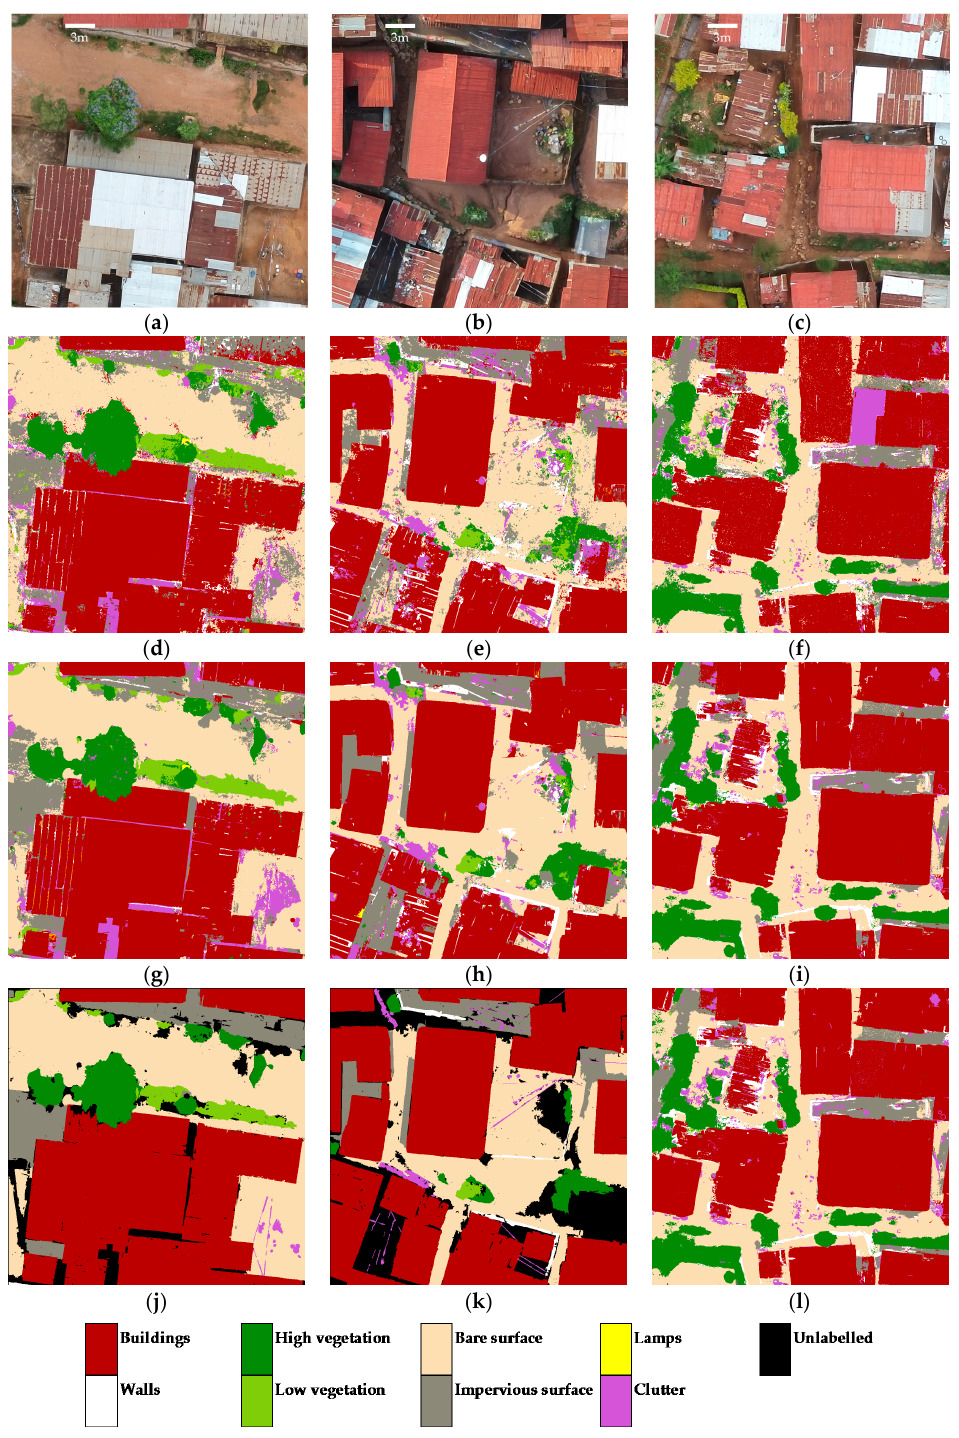
Figure 4. Sample classification results of three image tiles, with the input RGB tile in the first row ( a – c ); followed by the classification results using a standard single-kernel SVM ( d – f ); the classification results using the proposed CSMKSVM measure and the HSIC-f 45 feature grouping strategy ( g – i ); and the reference classification data ( j – l ).